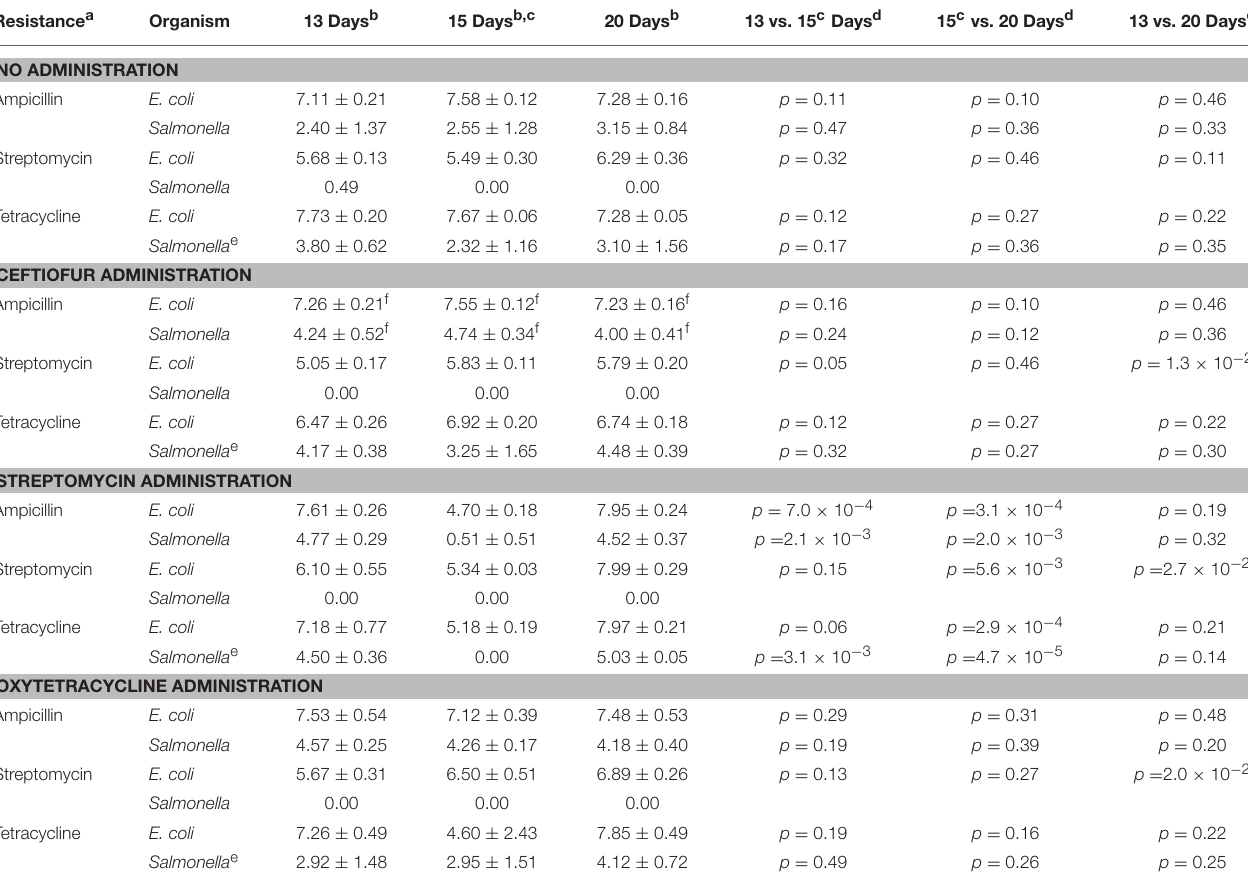
TABLE 6 | Impact of antibiotic administration on antimicrobial resistance in Gram-negative bacteria colonizing chickens. Resistance